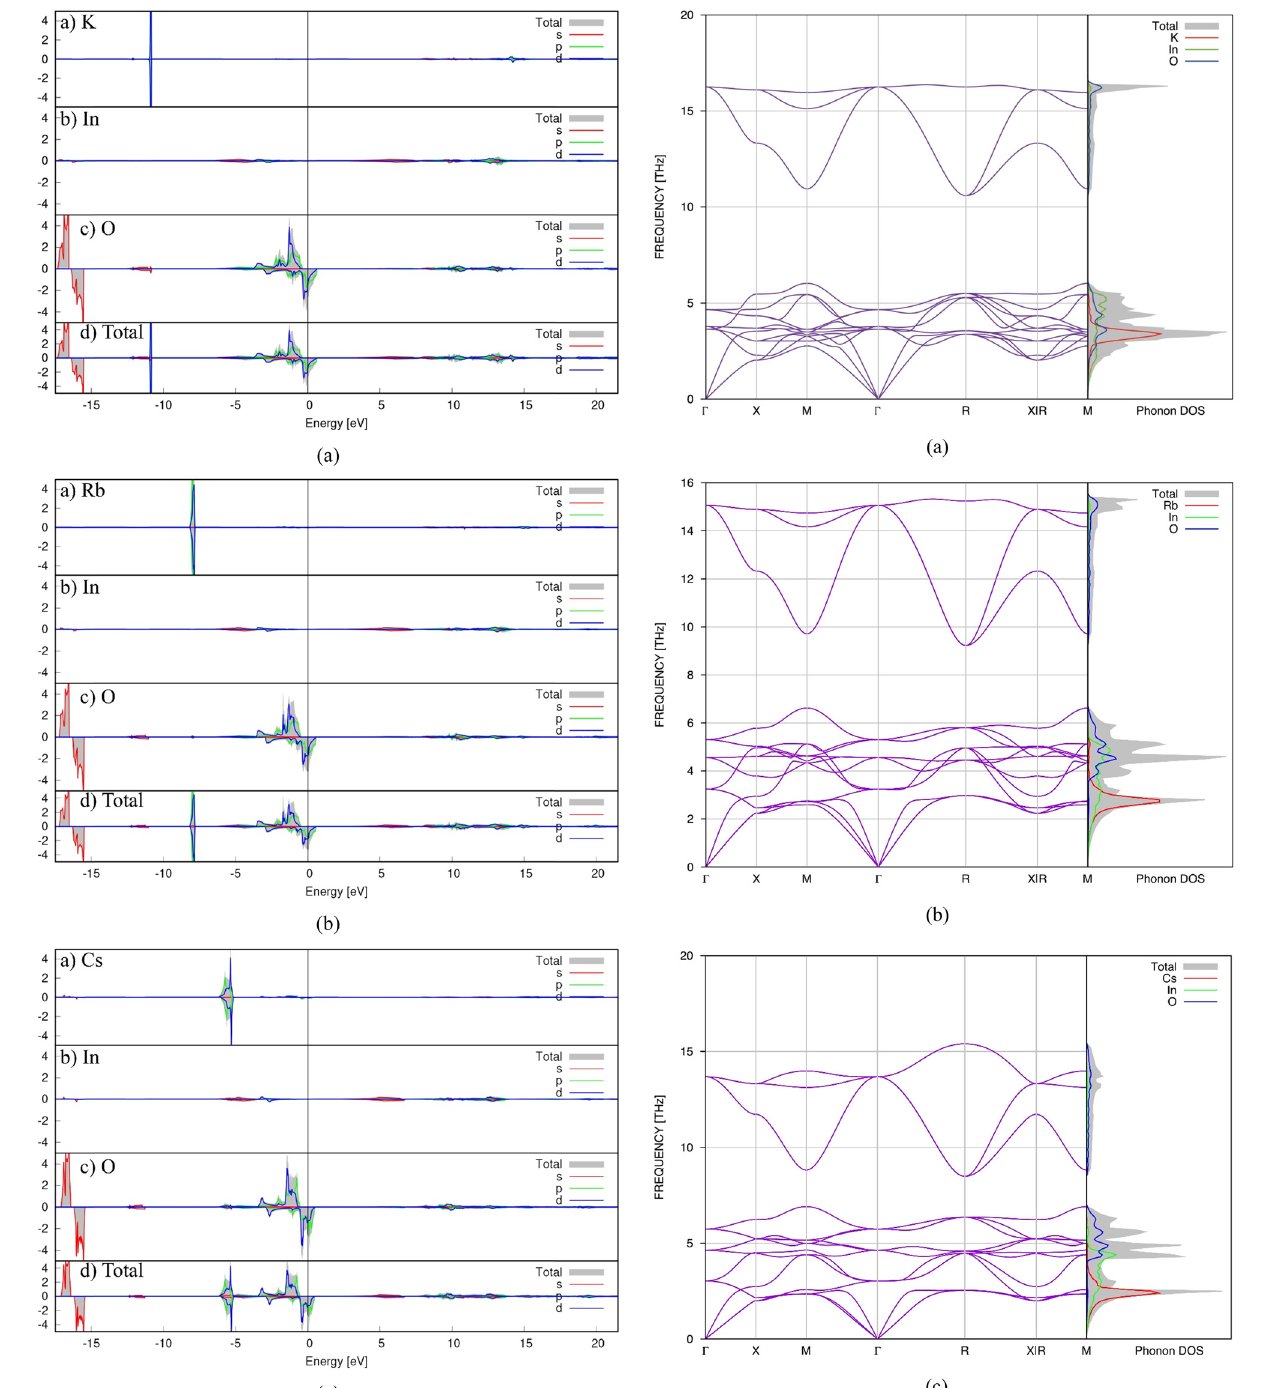
Figure 5: The calculated phonon dispersion curves and, relatedly, PDOS for XInO 3 ( X = K ( a ) , Rb ( b ) , and Cs ( c ))